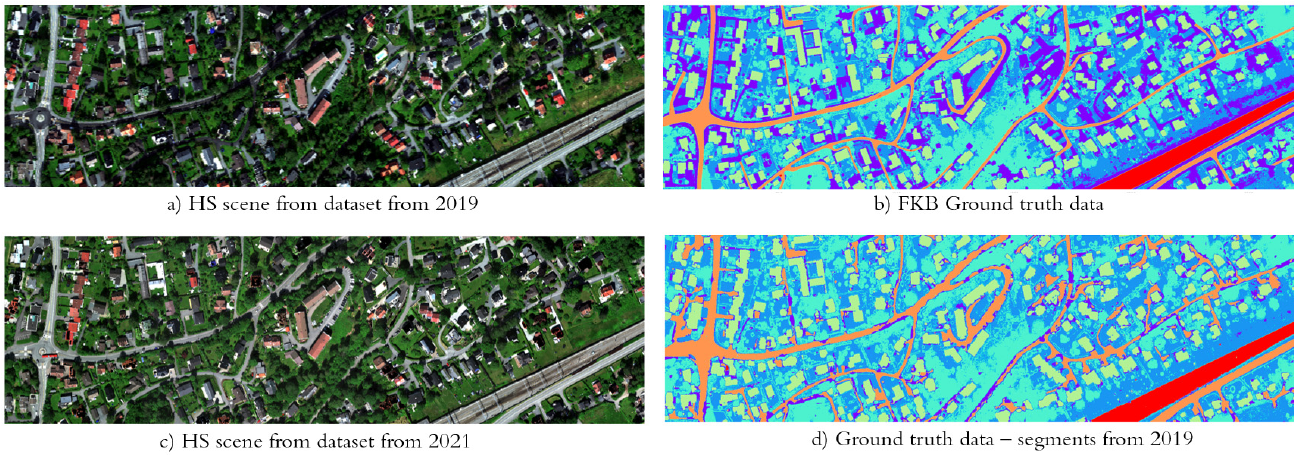
Figure 6. ( a ) HS scene from a dataset from 2019, ( b ) corresponding ground truth data, ( c ) HS scene from a dataset from 2021, and ( d ) corresponding ground truth data.